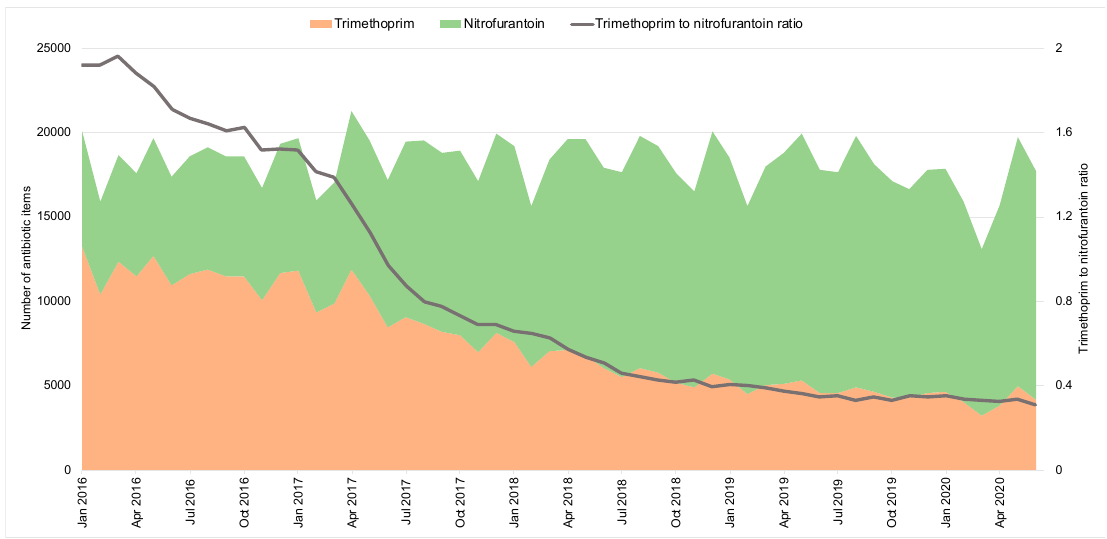
Between 2016 and 2020, there has been a consistent reduction in trimethoprim pre- scribing and the trimethoprim-to nitrofurantoin-ratio in OOH settings (Figure 4) from 1.9